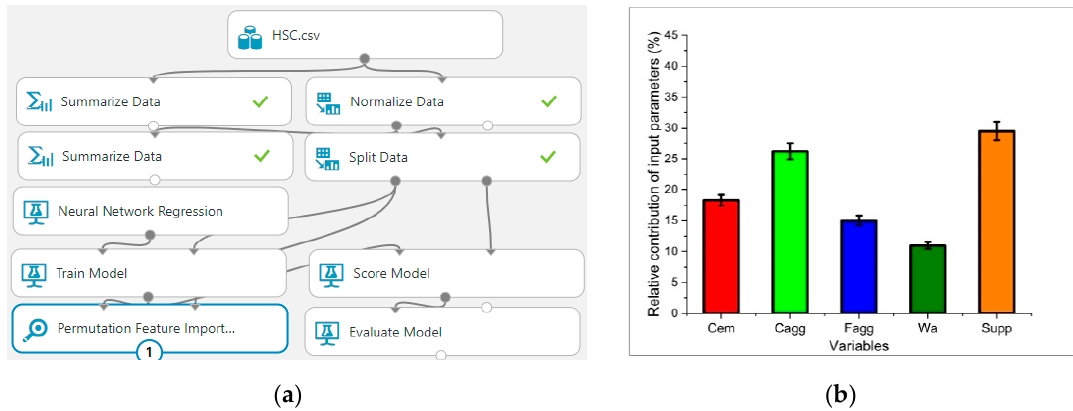
Figure 7. Permutation analysis of input variables ( a ) model base ( b ) contribution of input variables.